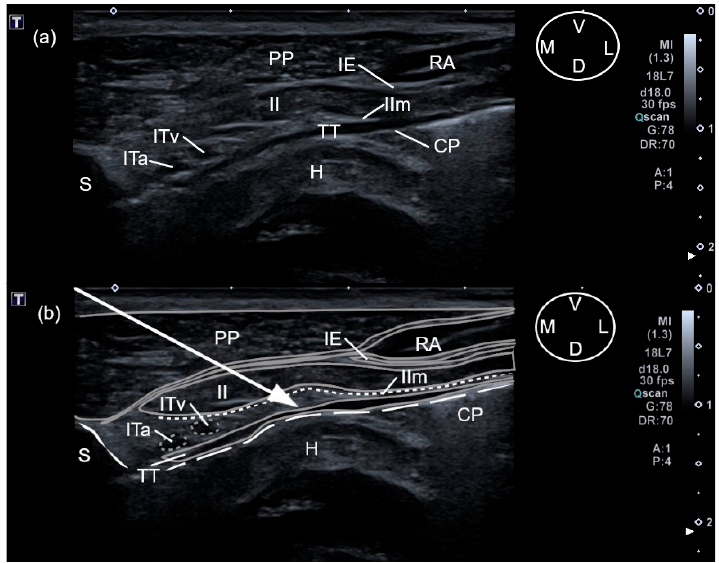
Figure 3. ( a ) Anatomical structures visualized during the two-point ultrasound-guided injection technique for the transverse approach to the transversus thoracis plane at the sixth intercostal space in a canine cadaver. ( b ) The same visualization of the anatomical structures with the edges of the muscles highlighted to improve the identification (solid grey lines), the internal intercostal membrane (short, dashed white lines), sixth sternebra (solid white line), vascular structures (short dashed grey lines) and costal pleura (long dashed lines). The arrow shows the pathway followed by the needle until reaching the transversus thoracis plane. CP, costal pleura; D, dorsal; H, heart; IE, external intercostal muscle; II, internal intercostal muscle; IIm, internal intercostal membrane; ITa, internal thoracic artery; ITv, internal thoracic vein; L, lateral; M, medial; PP, pectoralis profunda muscle; RA, rectus abdominis muscle; S, Sternum; TT, transversus thoracis muscle; V, ventral.